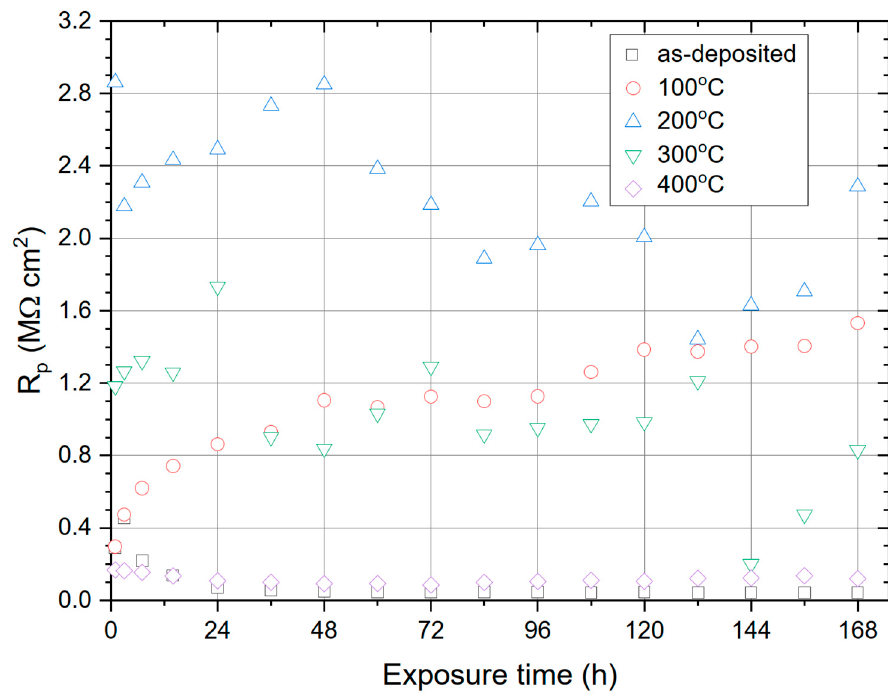
Figure 7. Polarization resistance measured in 0.05 mol dm − 3 solution of NaCl during 168 h of exposure of as-deposited Ni and heat-treated Ni coatings obtained in a plating bath composed of ChCl and EG (1:2 molar ratio) and 1 mol dm − 3 NiCl 2 · 6H 2 O (current density j c = 6 mA cm − 2 , 90 min, 70 ◦ C, coating thickness 7–8 µ